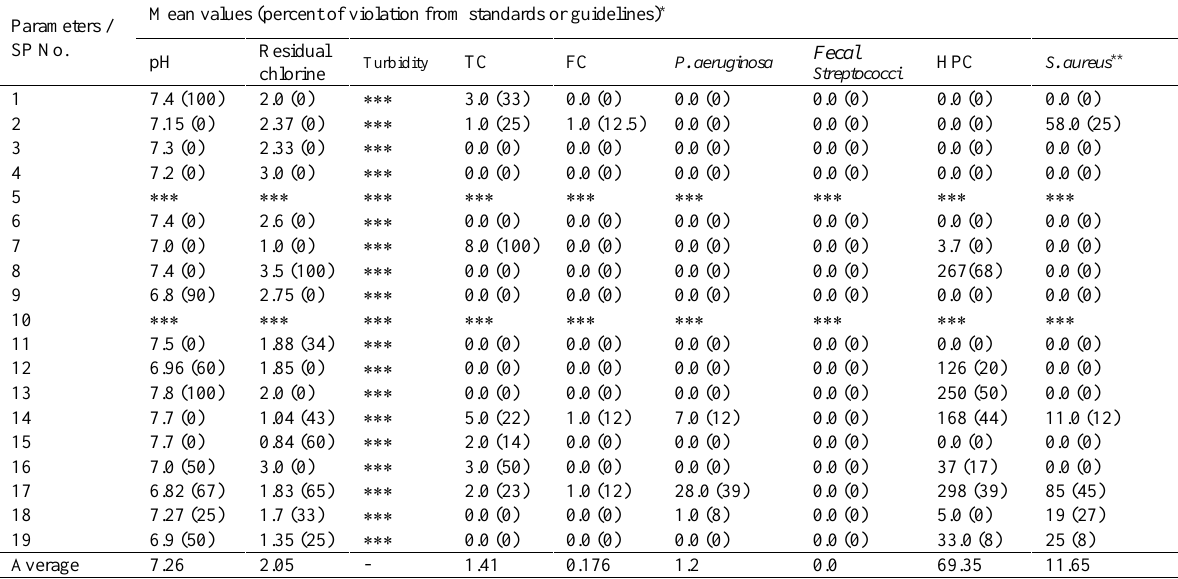
Table 3. Mean value of the assessed parameters in each swimming pool during 2013 Parameters / SP